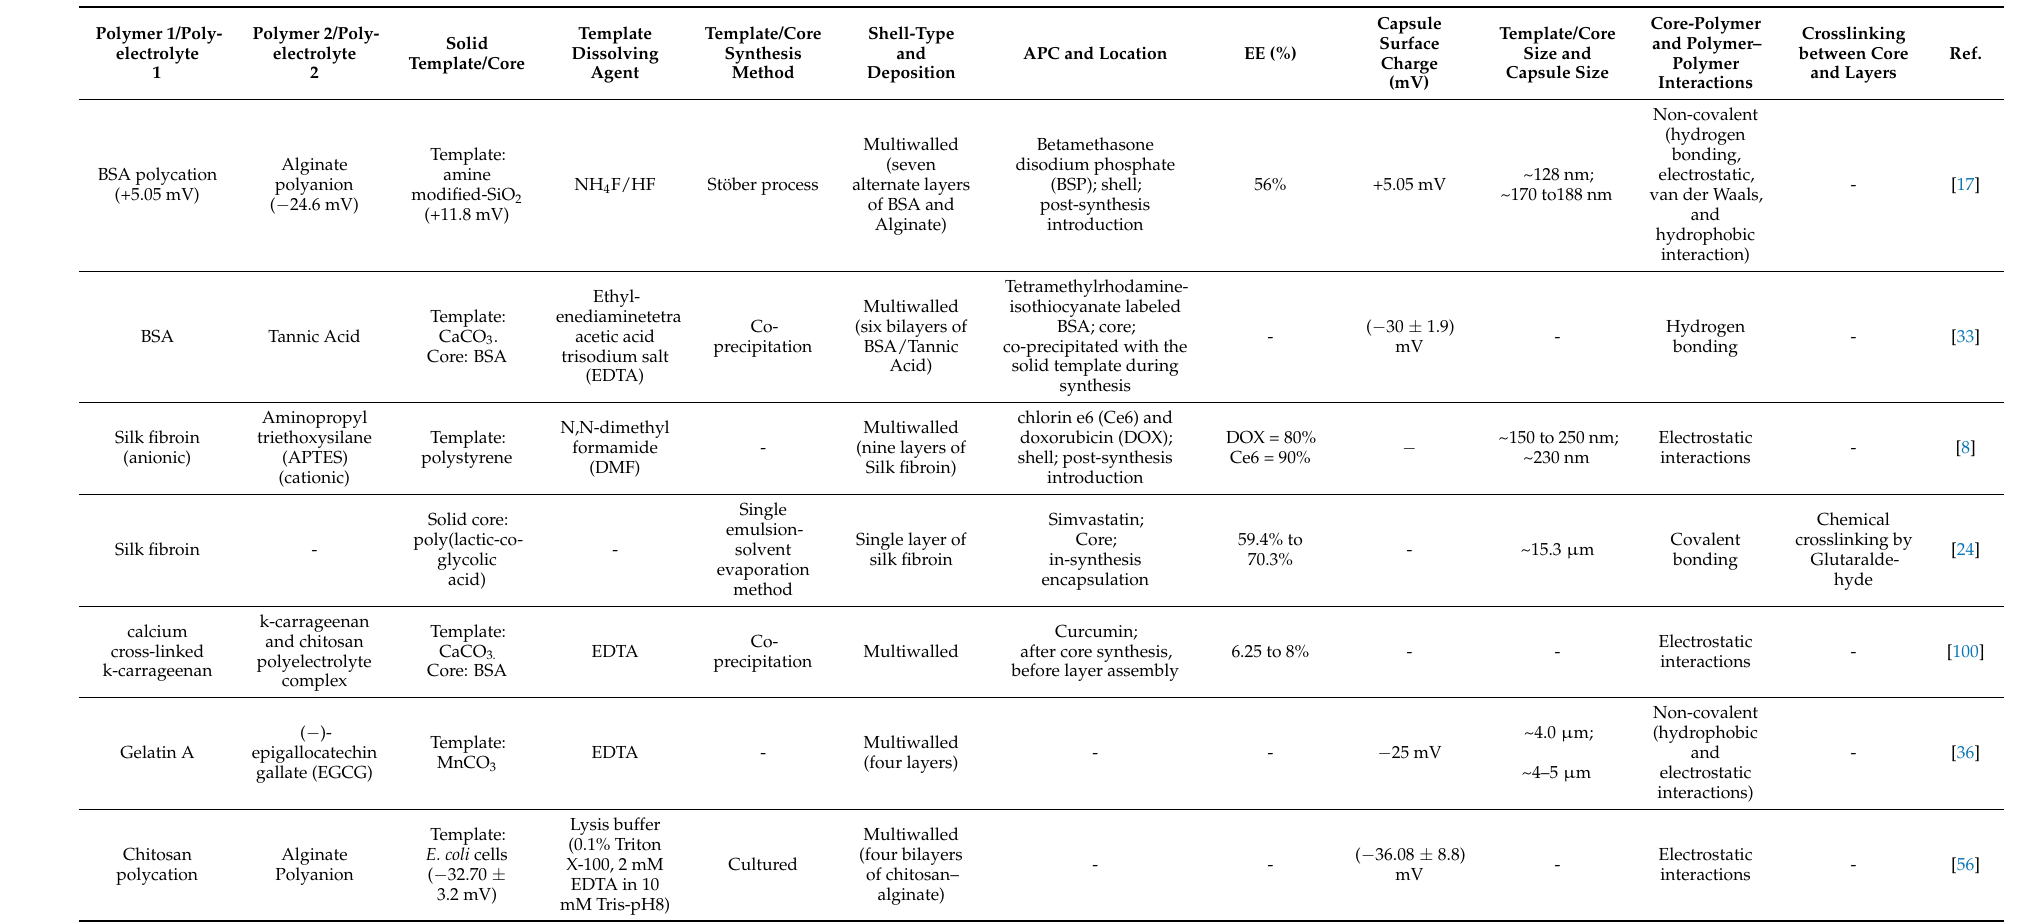
Table 2. Examples of capsules prepared by solid templating